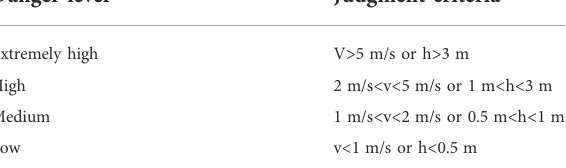
TABLE 4 Hazardous area classi fi cations.